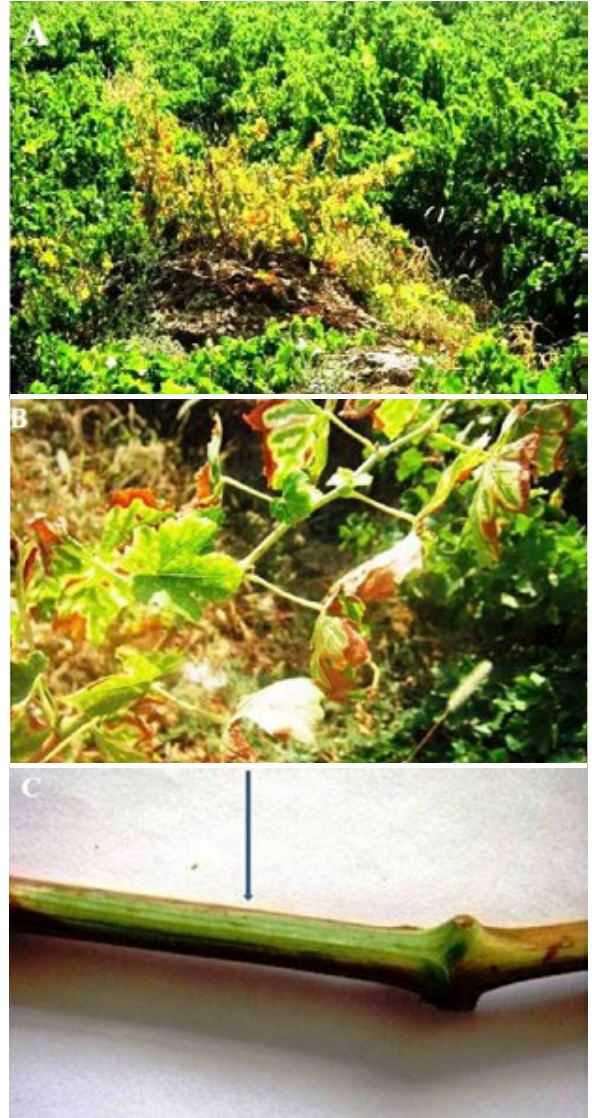
Figure 1. A. Grapevine plant with symptoms similar to PD in a vineyard. B. Grapevine leaves with marginal chlorosis and necrosis. C. Green island on a grapevine